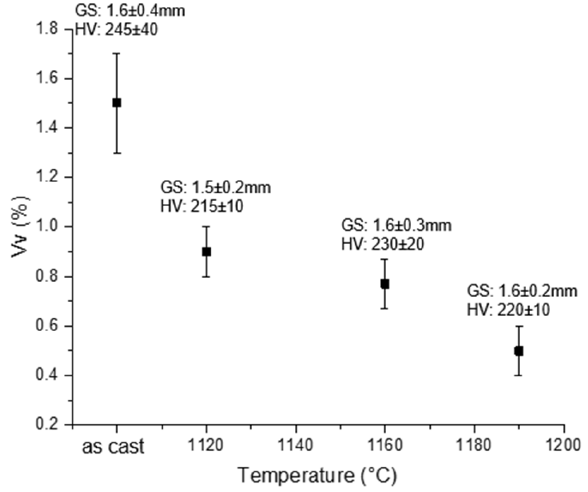
Figure 3. Scanning electron microscopy (SEM) images showing homogenization effect along grain boundaries ( a ) as cast and at ( b ) 1190 °C/4 h. boundaries ( a ) as cast and at ( b ) 1190 °C/4 h.